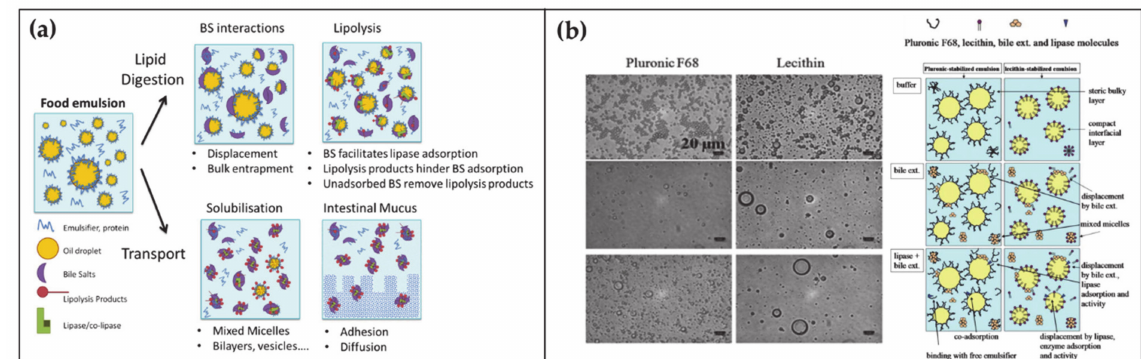
Figure 2. ( a ) Schematic representation of the BA functions and self-assembly during the lipid digestion and transport in the intestine (adapted from Macierzanka, A.; Torcello-G ó mez, A.; Jungnickel, C.; Maldonado-Valderrama, J. Bile Salts in Digestion and Transport of Lipids. Adv. Colloid Interface Sci. 2019 , 274, 102045. Ref. [46] with permission from (2019) Elsevier). ( b ) Transmission Electron Microscopy images of oil-in-water emulsions stabilized by two surfactants with interest in food and drug industry, namely Pluronic F68 and Lecithin (left top). Transmission Electron Microscopy images of the surfactant-emulsion transformation upon BA (left center) and BA + lipase addition (left bottom). Scheme representing the disposition of surfactant-BA-lipase at the oil/water interface (right). Reproduced from Torcello-G ó mez, A.; Maldonado- Valderrama, J.; Mart í n-Rodr í guez, A.; McClements, D.J. Physicochemical Properties and Digestibility of Emulsified Lipids in Simulated Intestinal Fluids: Influence of Interfacial Characteristics. Soft Matter 2011 , 7 , 6167–6177. Ref. [53] with permission from The Royal Society of